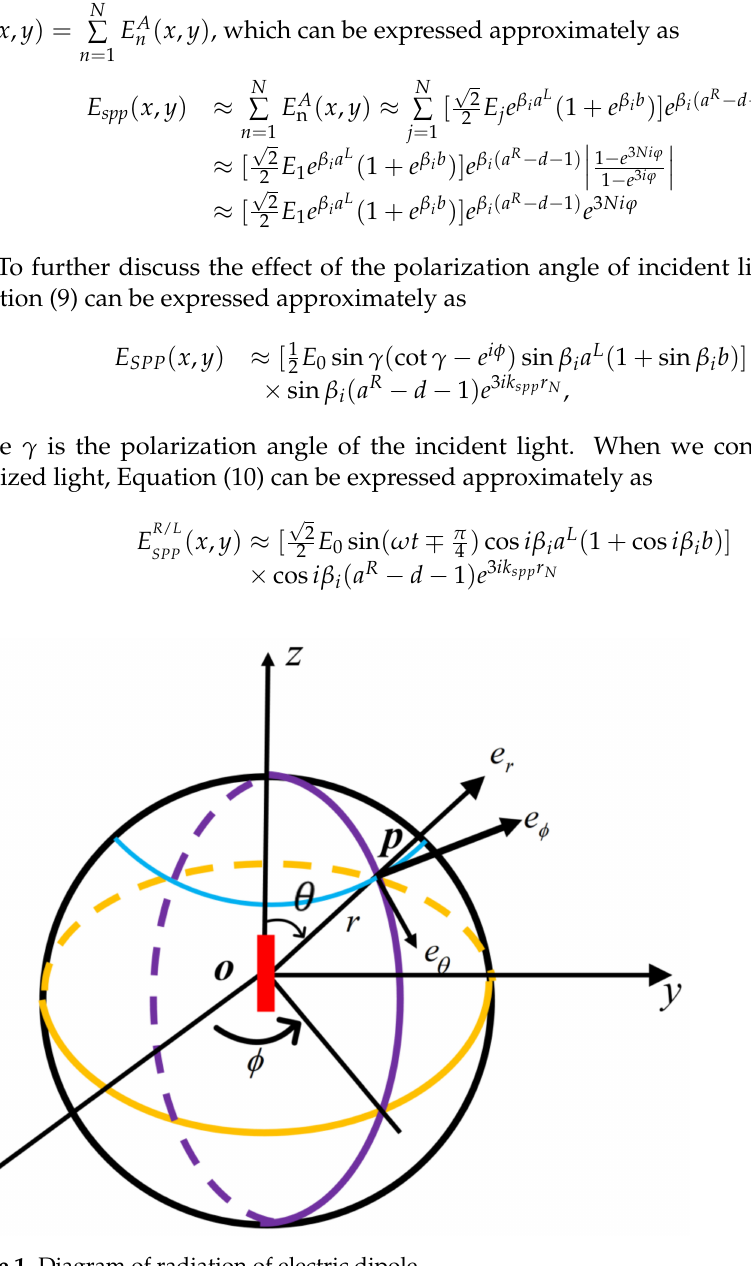
Figure 1. Diagram of radiation of electric dipole. That is, the electric field intensity of the SPB can also be controlled by changing the polarization angle of incident light and polarization state (LCP/RCP) of